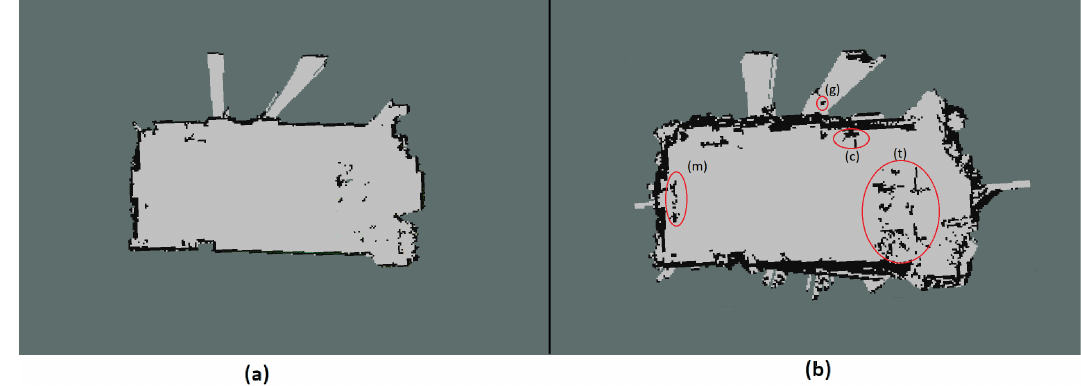
Figure 15. Two-dimensional Occupancy Grid used: ( a ) 2D laser scanner for mapping. ( b ) Fused sensor data for